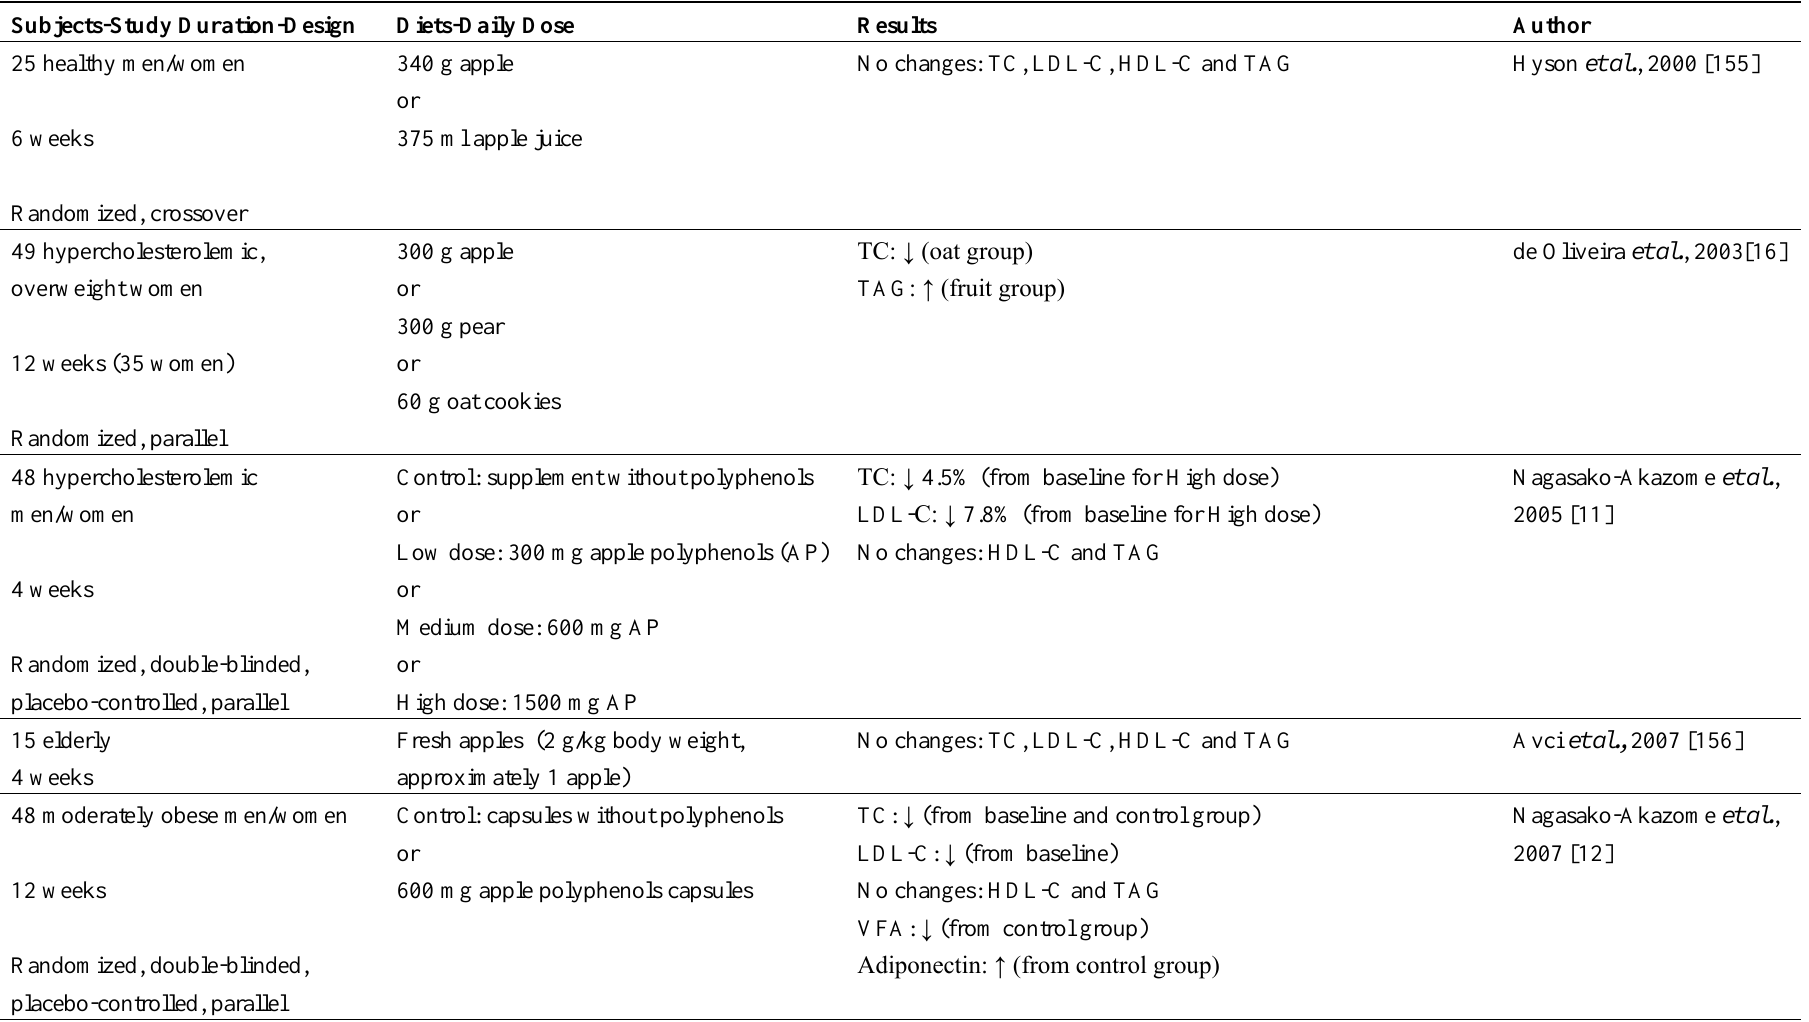
Table 4. Effects of apples and apple components on blood lipid levels in